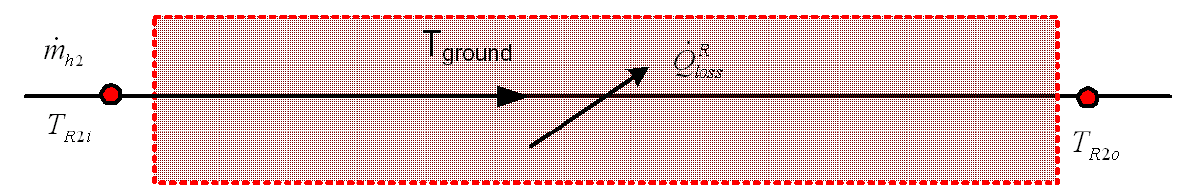
Figure 13. Heat loss model of return water